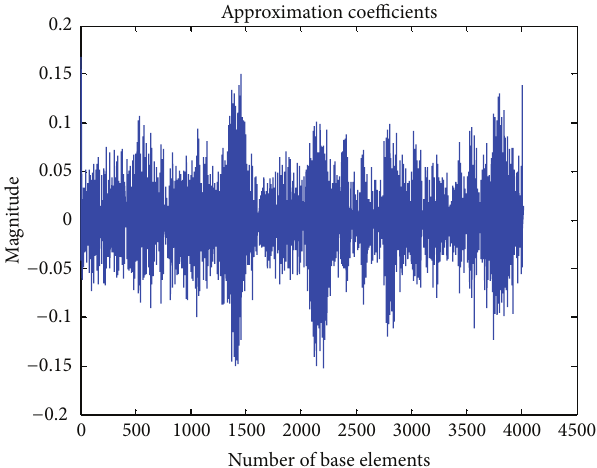
Figure 6: Approximate coefficients of DWT.